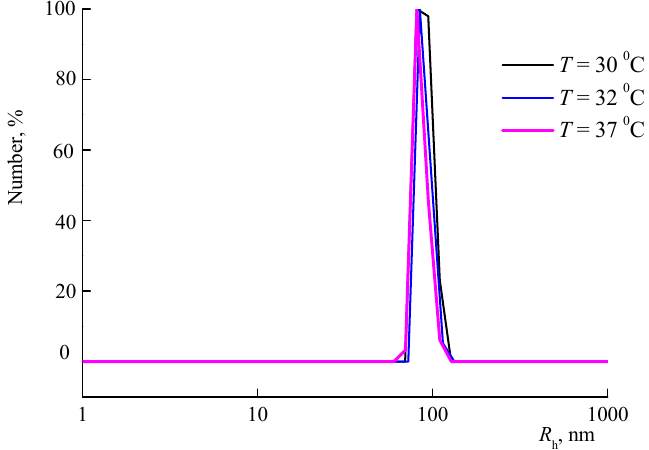
Figure 2. DLS curve of copolymer 1 in the aqueous solution at various temperatures.